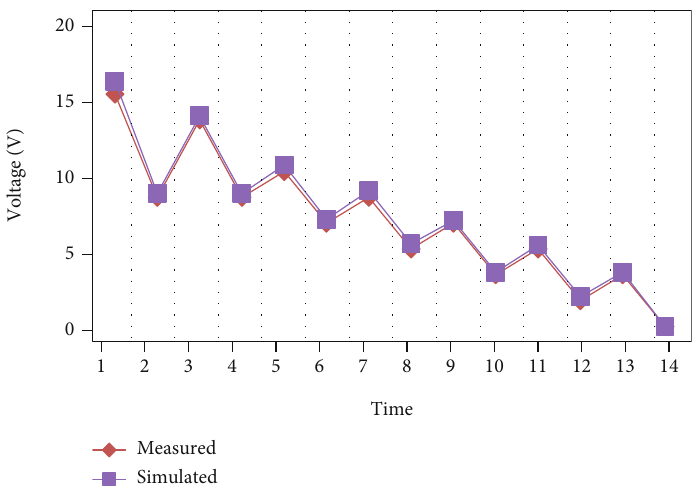
Figure 6: Yuasa NP18-12 battery, 0.2 pulse discharge. Table 2: Modi fi ed P&O algorithm ’ s di ff erent control